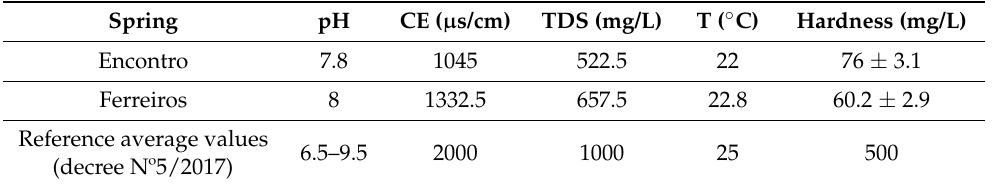
Table 2. Average of Brava water parameters. Spring